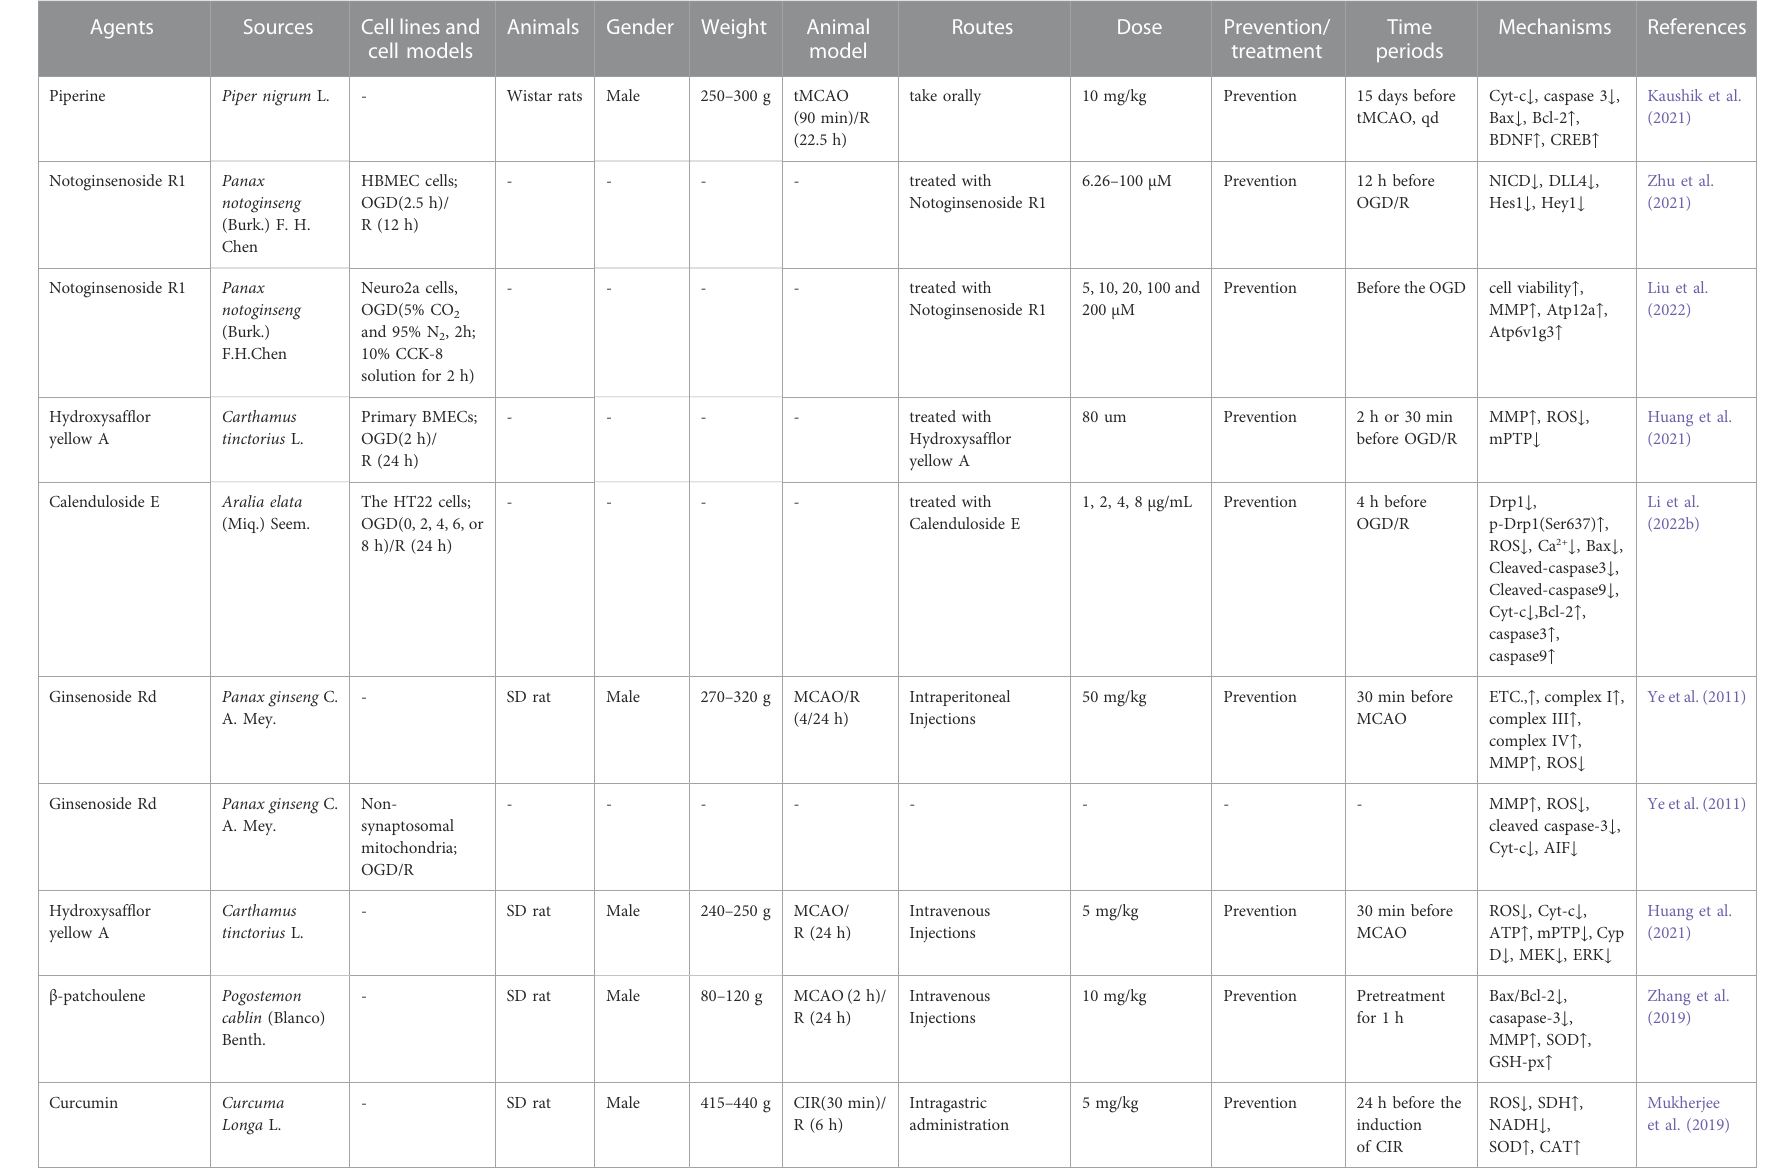
TABLE 3 The molecular mechanism of TCM compounds in the treatment of ischemic stroke by targeting